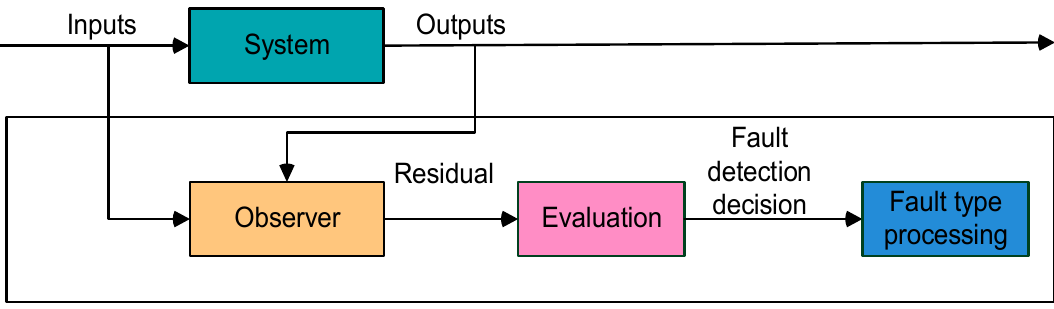
Figure 3. Proposed fault diagnosis scheme.